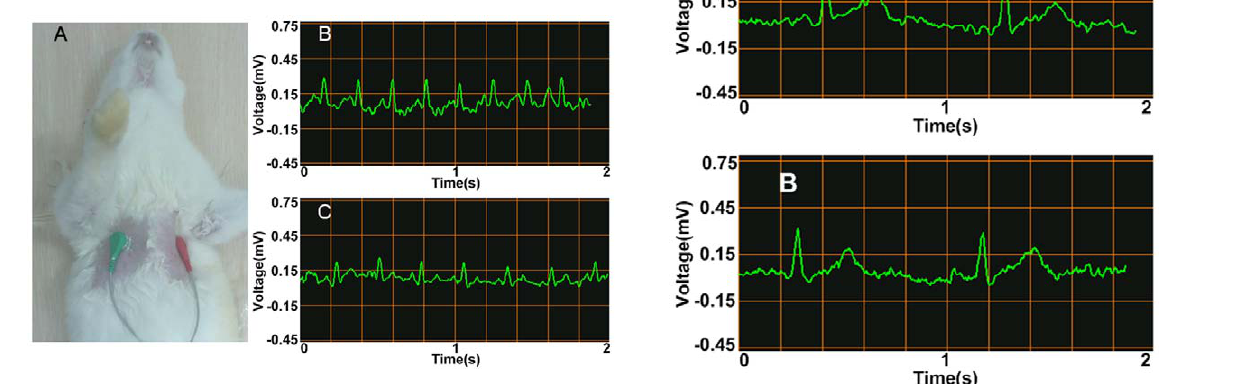
Figure 5. ECG test results on human. (A) Results using button electrode; (B) Results using liquid metal